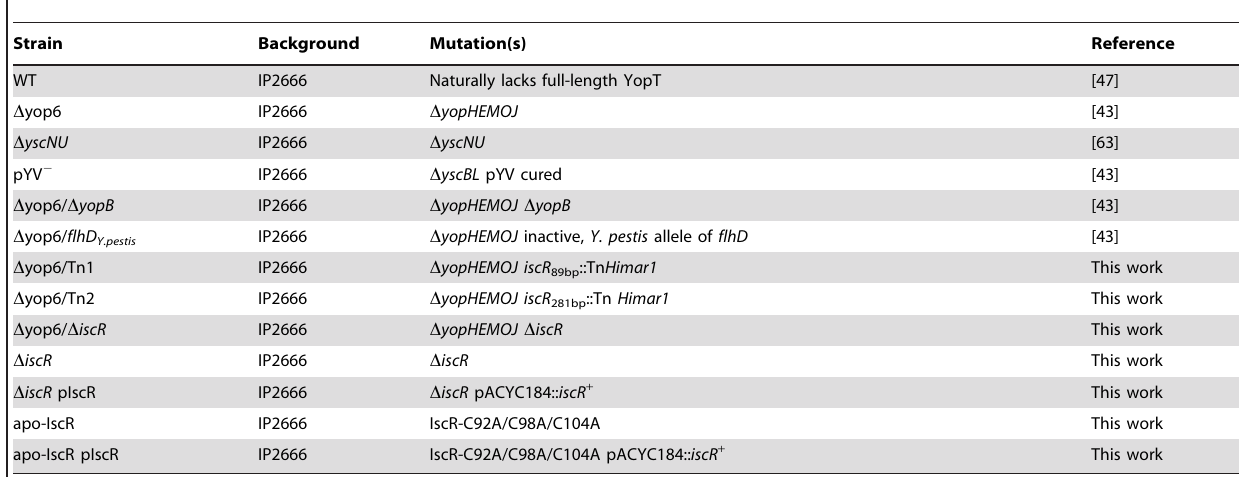
Table 3. Y. pseudotuberculosis strains used in this